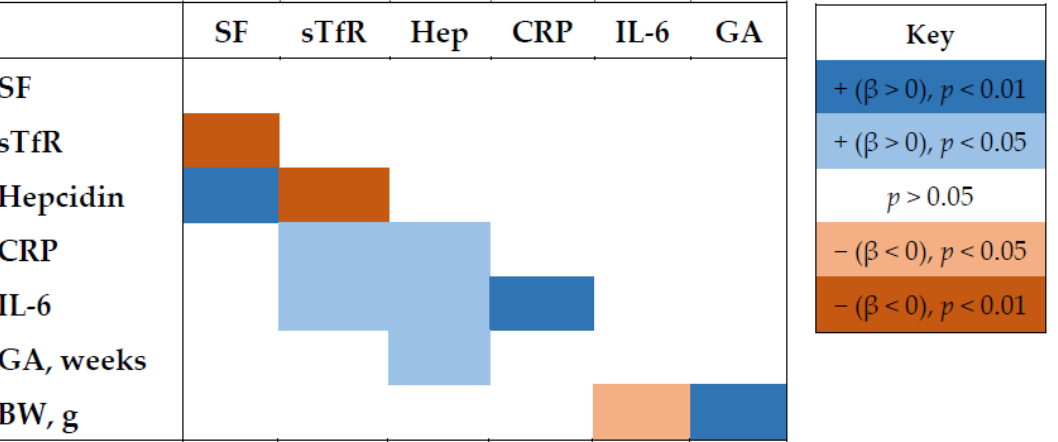
Figure 1. Prevalence of ID by selected maternal and infant characteristics. Bar height indicates the prevalence of ID within each level of the characteristic. Error bars indicate the standard error of the estimated prevalence. Prevalence and standard errors were estimated with mixed effect linear regression models with a random effect for twin pair. Prevalence differences did not reach statistical significance in mixed effects models. ID, iron deficiency.